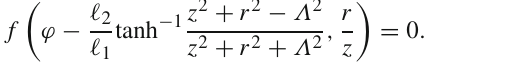
the boundary CFT with respect to the regions separated by the entangling surface (entangling curve in AdS 4 ). Therefore,